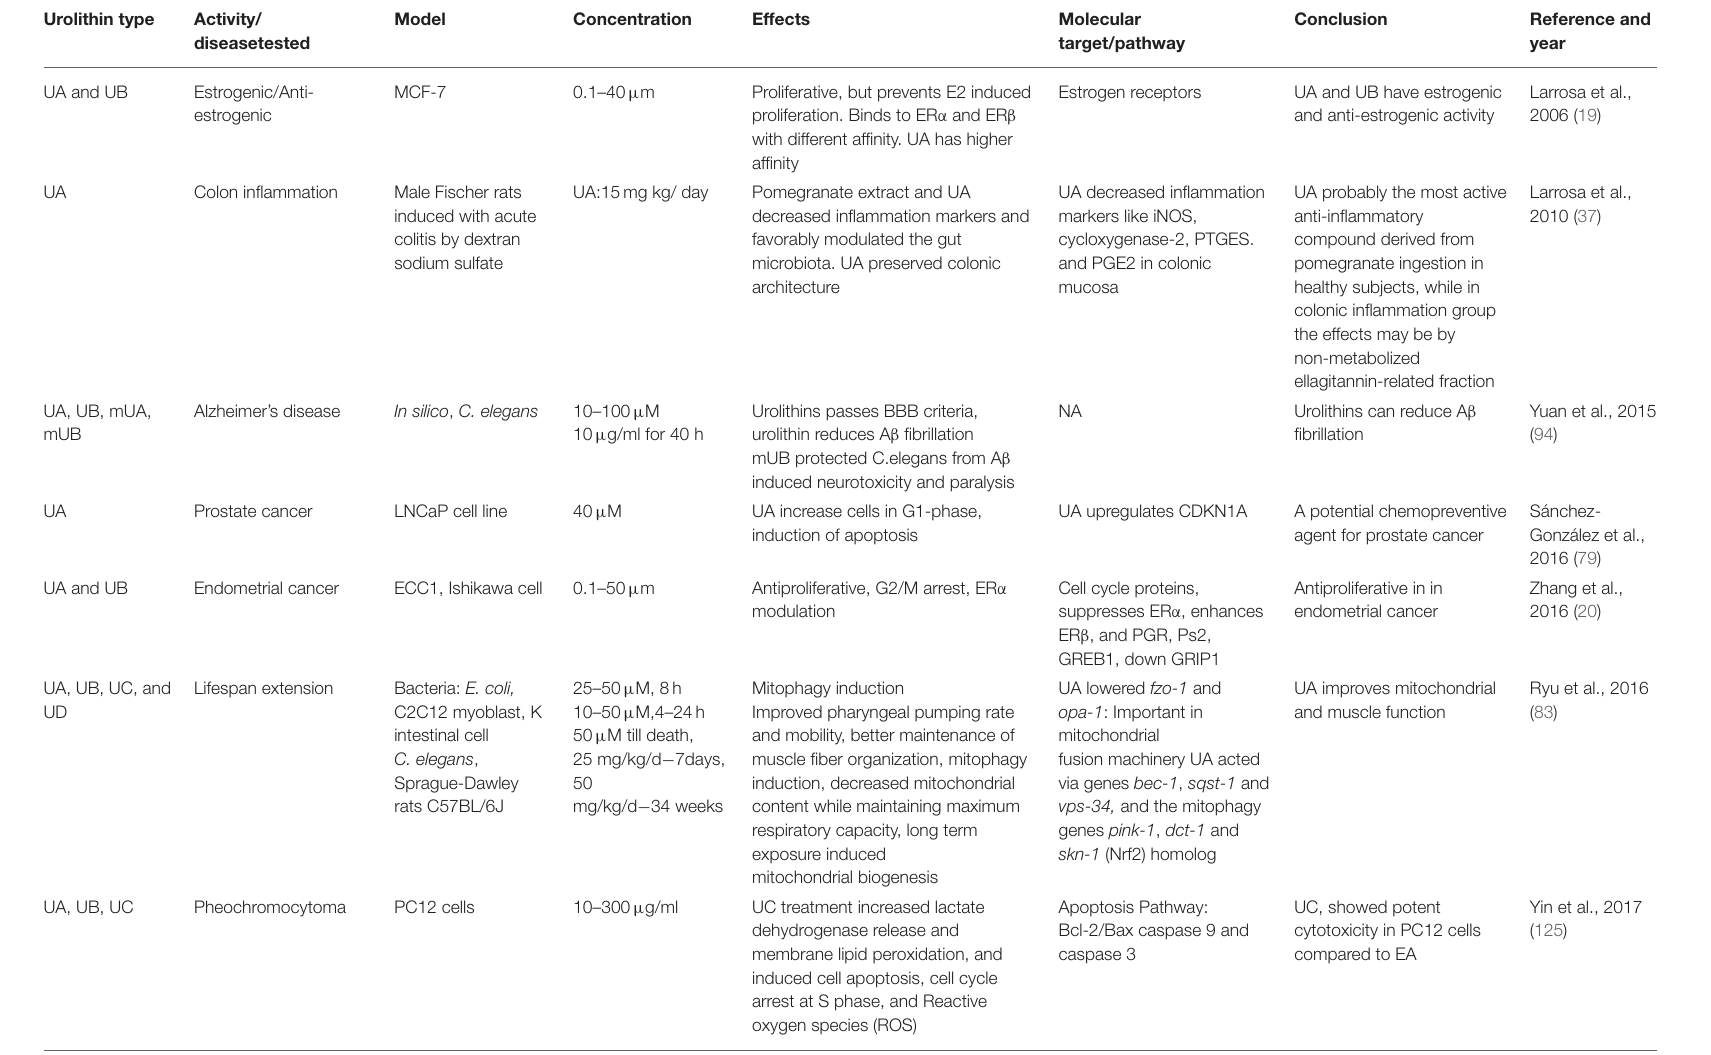
TABLE 1 | The table consolidates the relevant studies related to Urolithins and their significant